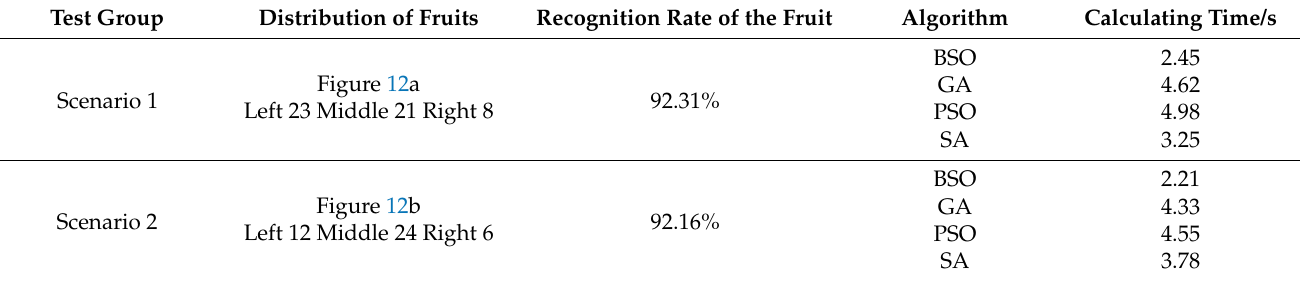
Table 4. Kiwifruit planning test results.